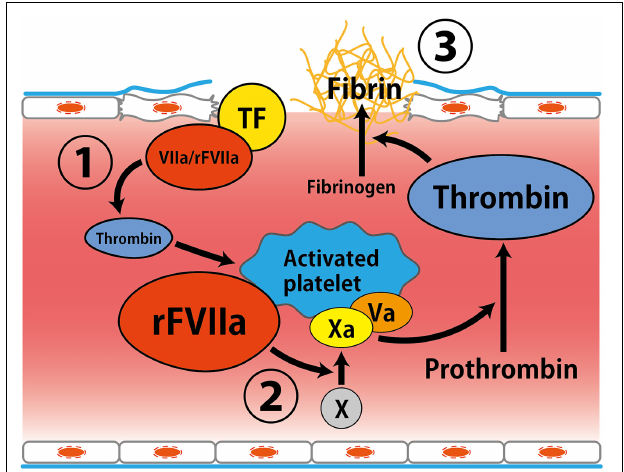
FIGURE 1 | Putative mechanism of hemostatic action by recombinant activated factor VII. (1) Factor VIIa interacts with tissue factor expressed by activated endothelial cells at the site of vessel wall injury, leading to thrombin generation. (2) Amplification of thrombin formation by rFVIIa on the surface of activated platelets. (3) Thrombin converts fibrinogen to fibrin (Monroe et al., 1997; Hoffman and Monroe, 2001). Abbreviations: TF, tissue factor; rFVIIa, recombinant activated factor